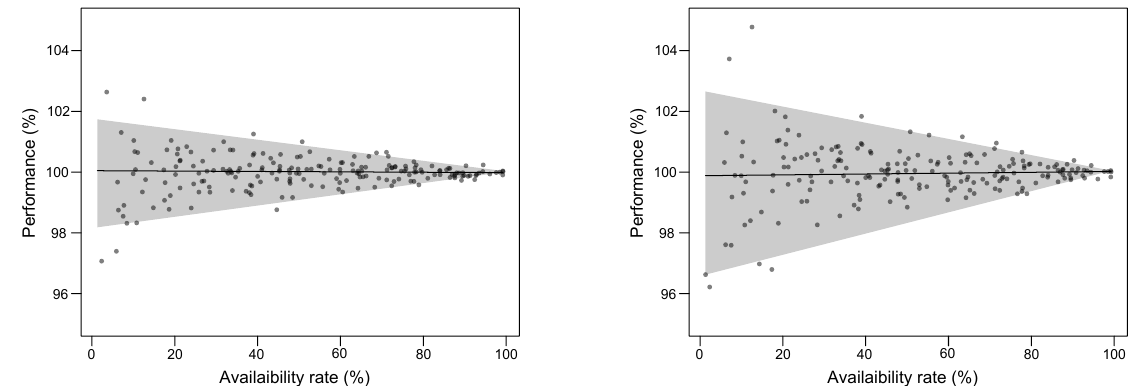
Figure 9. Variety of the performance ( y -axis) according to the data availability in the test period ( x -axis). One point represents one trial run for a given availability rate. The solid line represents the median spline, while the grey filled zone represents the confidence interval 5–95% induced by the availability